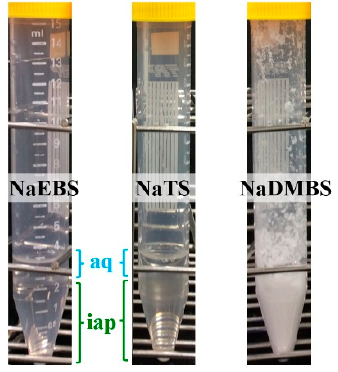
Figure 2. Photographs of BTC and some organic anions mixed with water and left overnight. Organic anion sources: sodium ethylbenzenesulfonate (NaEBS, left); sodium toluenesulfonate (NaTS; center); and sodium dimethylbenzenesulfonate (NaDMBS, right); aq: aqueous phase, iap: ion-associate phase. The solutions contain 3 mmol BTC, NaEBS, NaTS, and NaDMBS in 120 mmol water. The % E of the six PAHs in IAPs formed from BTC and EBS − or TS − was determined. IAPs from BTC-EBS − show higher % E s than those from BTC-TS − (Figure 3). Thus, IAPs from BTC-EBS − are more suitable as model IAPs than those from BTC-TS − .